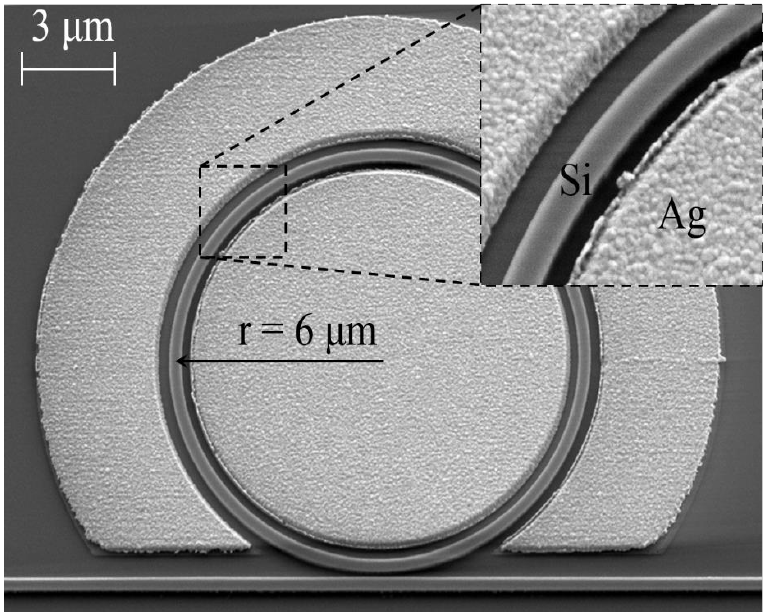
Figure 4. Scanning electron microscope picture of the fabricated double-slot hybrid plasmonic ring